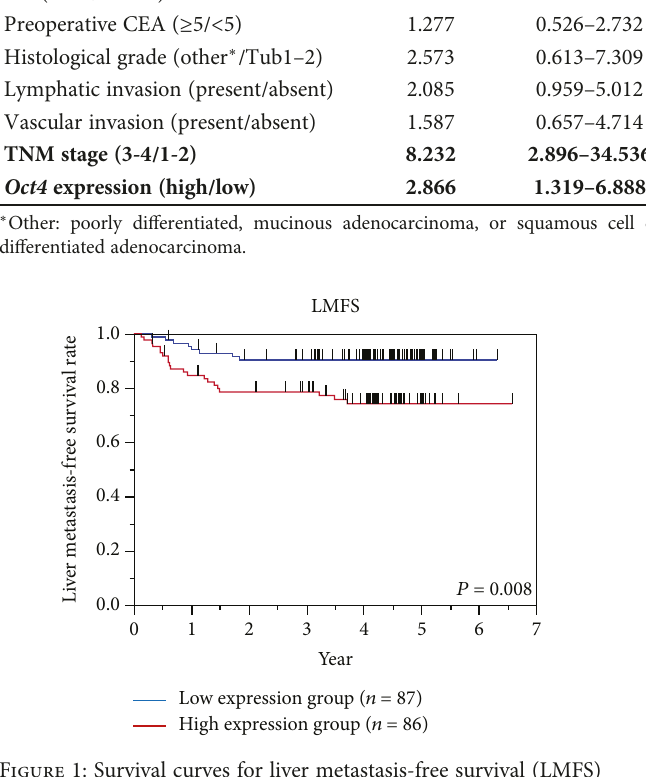
Figure 1: Survival curves for liver metastasis-free survival (LMFS) according to Oct4 mRNA expression. The patients were divided into two groups according to the median value of the Oct4/GAPDH mRNA expression level of primary tumor. The 5-year LMFS rate was 90% ( n = 87 ) in the low-expression group and 74% ( n = 86 ) in the high-expression group ( P = 0 008